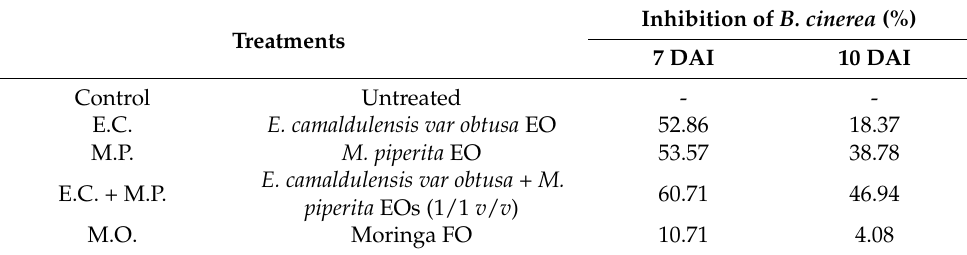
Table 9. Mycelial growth inhibition determined according to the diameters of the lesions for different treatments at 7 and 10